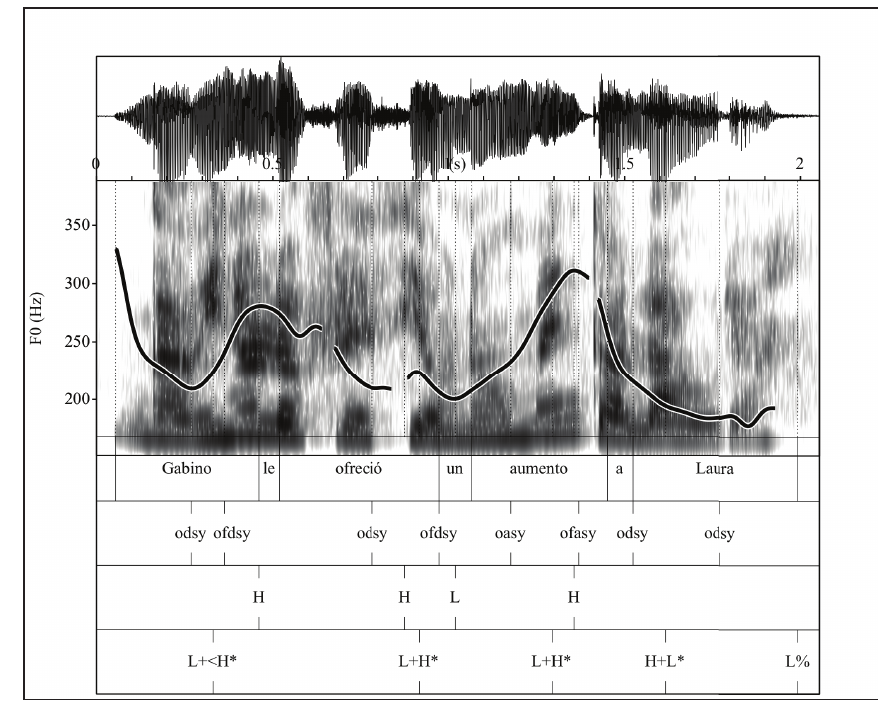
Figure 8: The utterance Gabino le ofreci ó un aumento a Laura ‘Gabino offered a raise to Laura’ as produced by participant